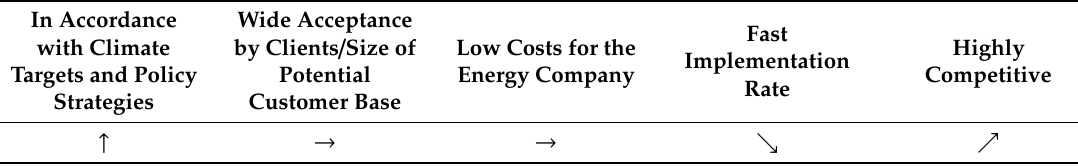
Assessment of dynamic electricity pricing for companies as a business model for energy